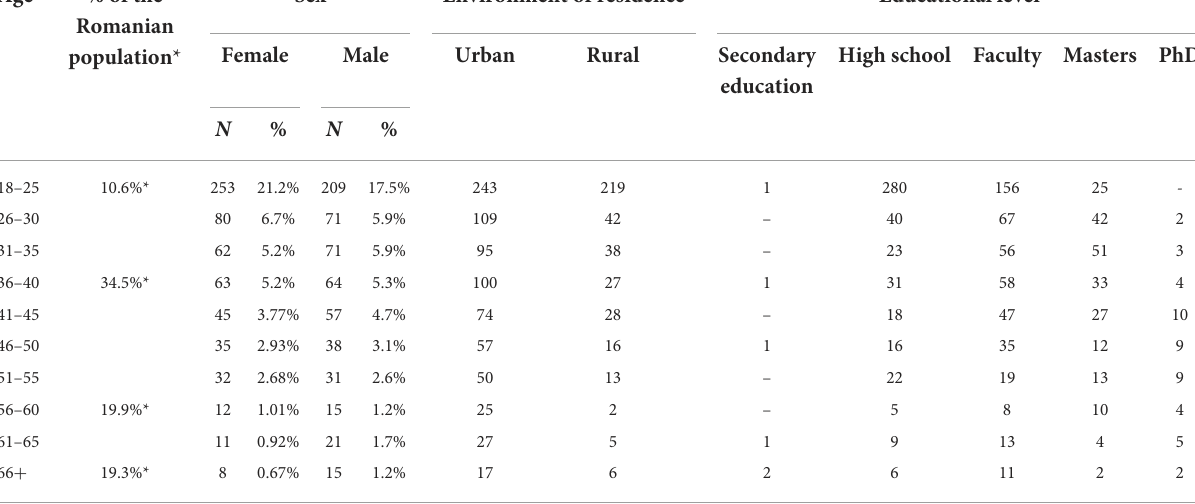
TABLE 3 Socio-demographic data of the participants. Age % of the Romanian population *